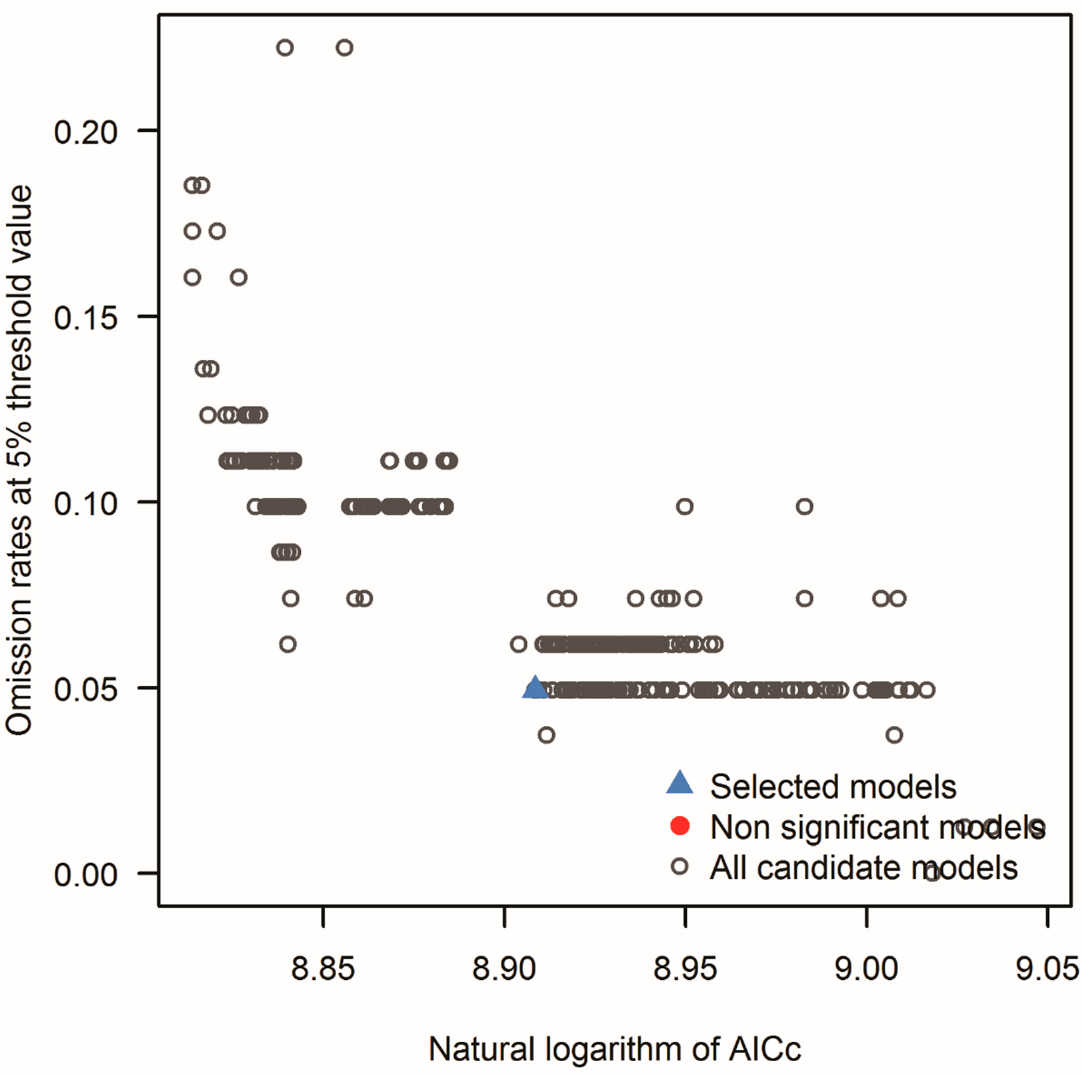
1 Table 7. Performance statistics for the best models selected. Model